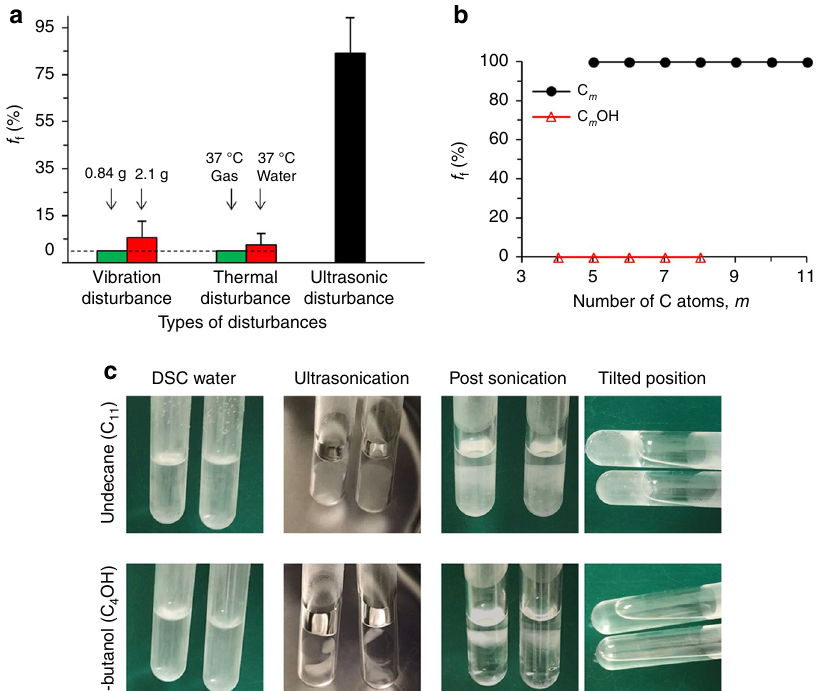
Fig. 4 Stability tests for 1 ml deep-supercooled water at − 20 °C. a f f of deep-supercooled (DSC) water sealed by MO under various disturbances. Vibrational disturbance was imposed by shaking plate with different shaking frequencies and centrifugal forces (i.e., 0.84 g or 2.1 g). Thermal disturbance was imposed by placing or plunging the DSC tubes into 37 °C incubator (37 °C gas) or water bath (37 °C water). Ultrasonic disturbance was introduced by putting the DSC tubes into 40 kHz ultrasonic water bath. n = 6, N = 48. Error bars represent standard deviations. b f f of DSC water sealed by linear alkanes and primary alcohols under 40 kHz ultrasonic disturbance. n = 3, N = 24 (except for C 5 , N = 8). c Representative image sequences of ultrasonication tests for DSC water sealed by linear alkanes or primary